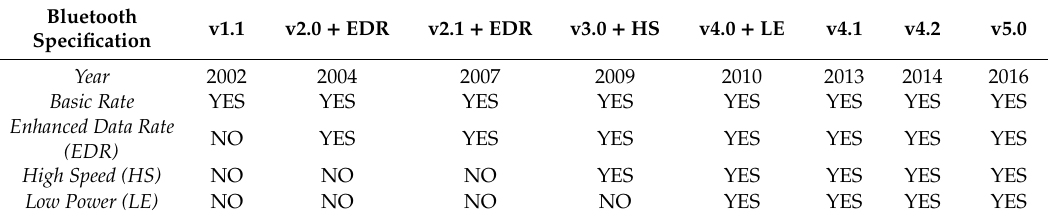
Table 1. Bluetooth characteristics [5].